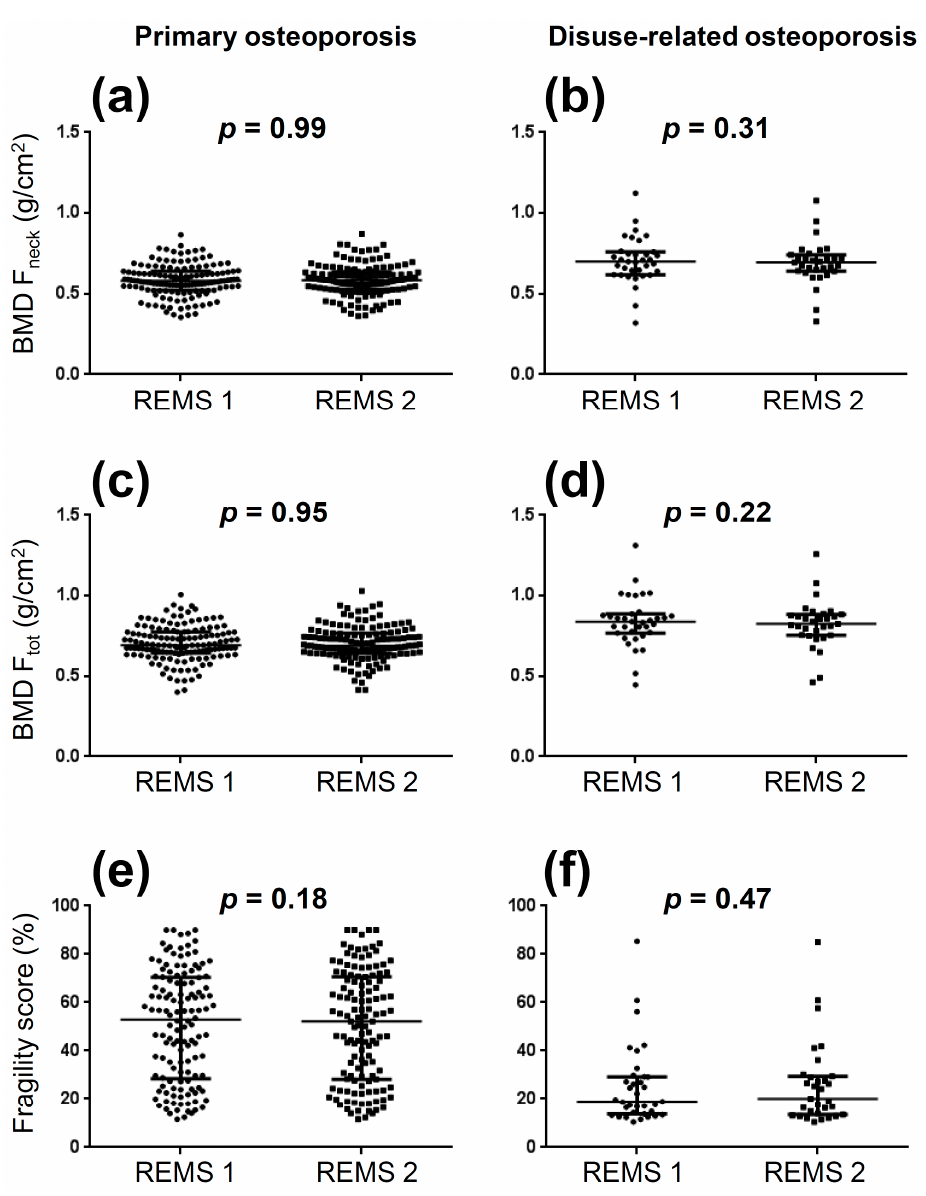
Figure 1. Values of femoral neck bone mineral density (BMD F neck : panels ( a , b )), total femur bone mineral density (BMD F tot : panels ( c , d )), and fragility score (panels ( e , f )) obtained for the two REMS acquisitions (REMS 1 vs. REMS 2) in patients with primary osteoporosis (left panels) and disuse-related osteoporosis (right panels).